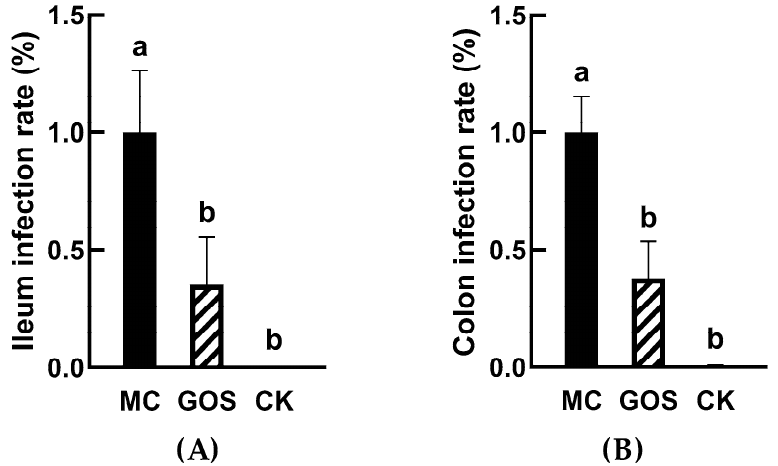
Figure 1. E. coli O157 colonization in ileum and colon ( A ) Colonization in ileum; ( B ) Colonization in colon. Different letters (a,b) showed significant difference ( p < 0.05).